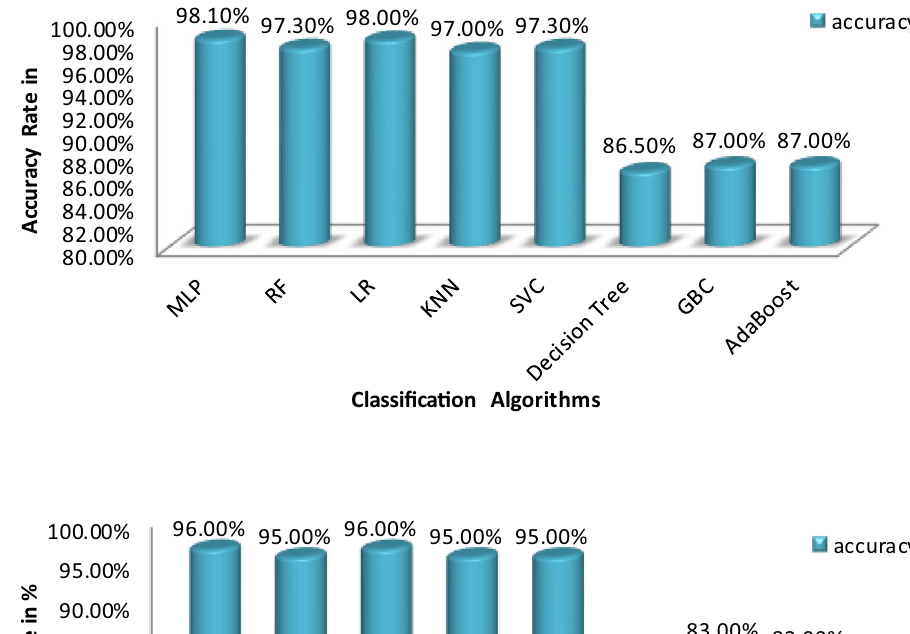
Fig. 9 Highest accuracy com- parison of different classifica- tion algorithms